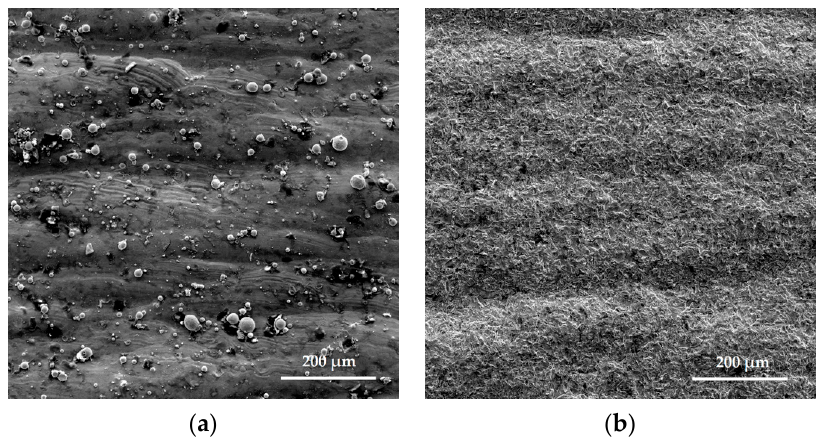
Figure 9. SEM-image in secondary electrons of the surface produced from 12kH18N9T (AISI 321) anticorrosion steel powder: ( a ) after laser powder bed fusion method, 500 × ; ( b ) after vibratory tumbling, 502 × .